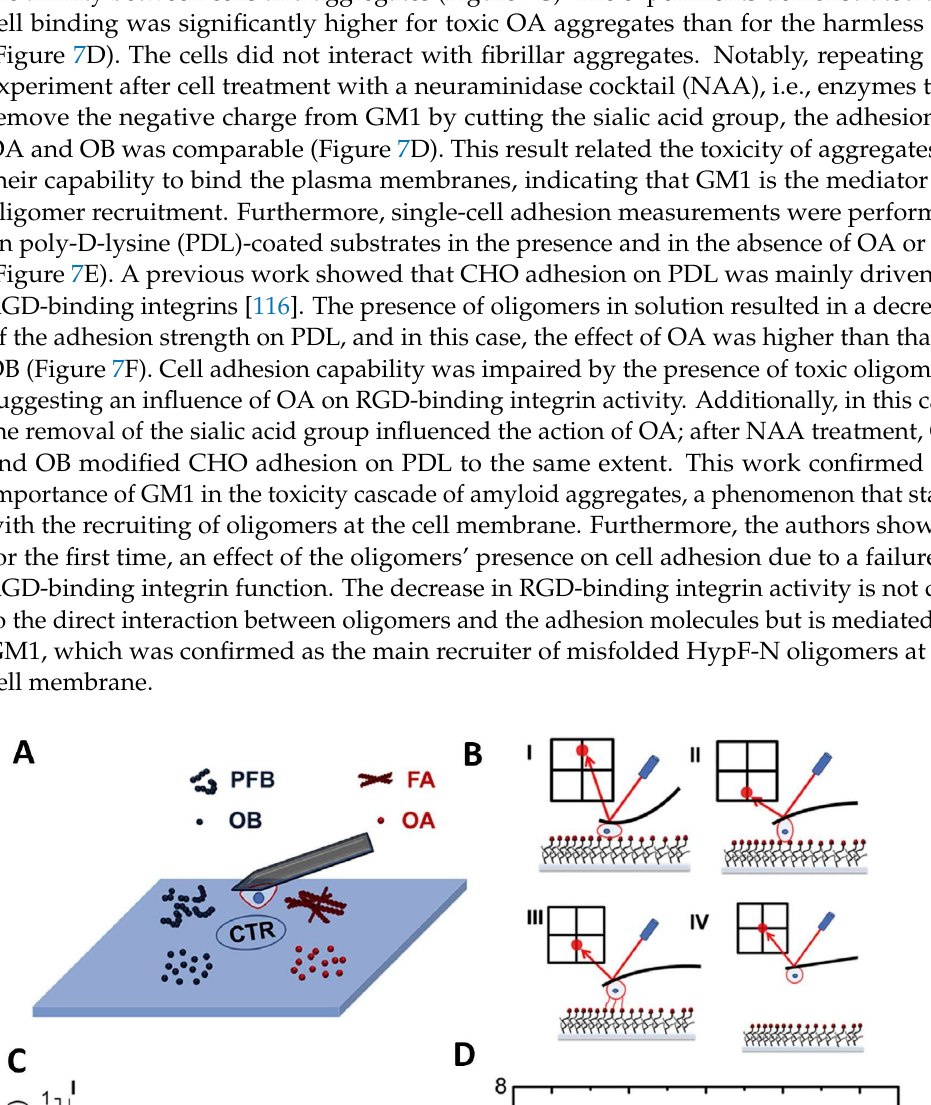
Figure 7. ( A ) Schematic representation of the experimental setup with OA, OB, FA, and PFB aggre- gates on different regions of the functionalized glass substrate. ( B ) Cartoon of the four steps of the experiment. First, the cell was in contact with the functionalized substrate under a defined force (I); then, the AFM cantilever moved away from the substrate until the maximal adhesion force was reached. At this time, no adhesion interactions have been broken and the cantilever was applying a traction force on the cell (II). The cell was then gradually detached from the substrate; the detach- ment process was characterized by several rupture events, corresponding to jumps of the traction force (III). A final plateau at a force of 0 nN was reached when the cell was fully detached (IV). ( C ) Typical F–D curve acquired using SCFS with the four steps described in ( B ). The detachment work (W), represented by the gray area below the baseline at a force of 0 nN, quantifies the interaction between the cell and the substrate. ( D ) Mean work spent to detach the cell from the substrate (W) for the various aggregate types and obtained from cells treated and not treated with NAA. Error bars correspond to standard deviations. * and *** indicate p ≤ 0.05 and p ≤ 0.001, respectively, relative